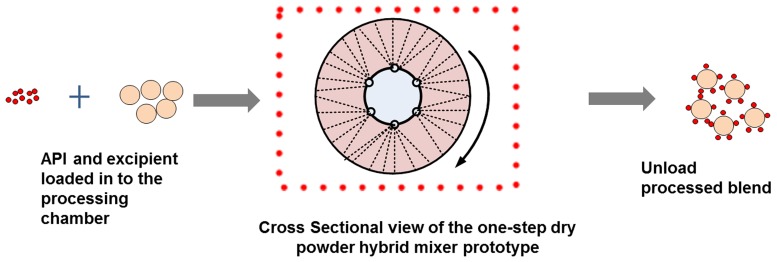
Schematic showing the process of dry powder hybrid mixing.Fine guest material (API) and coarse carrier (Excipient) are added to the high G-force processing vessel coupled with air blade (nitrogen gas) under highly controllable conditions to produce final interactive blend.